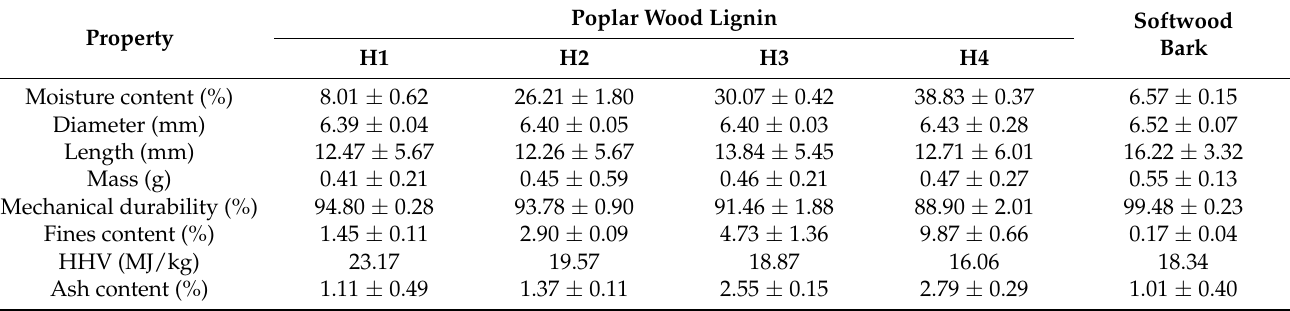
Table 2. Physical properties of the poplar wood lignin and softwood bark pellets produced using the laboratory-scale pellet mill following scenario 1.